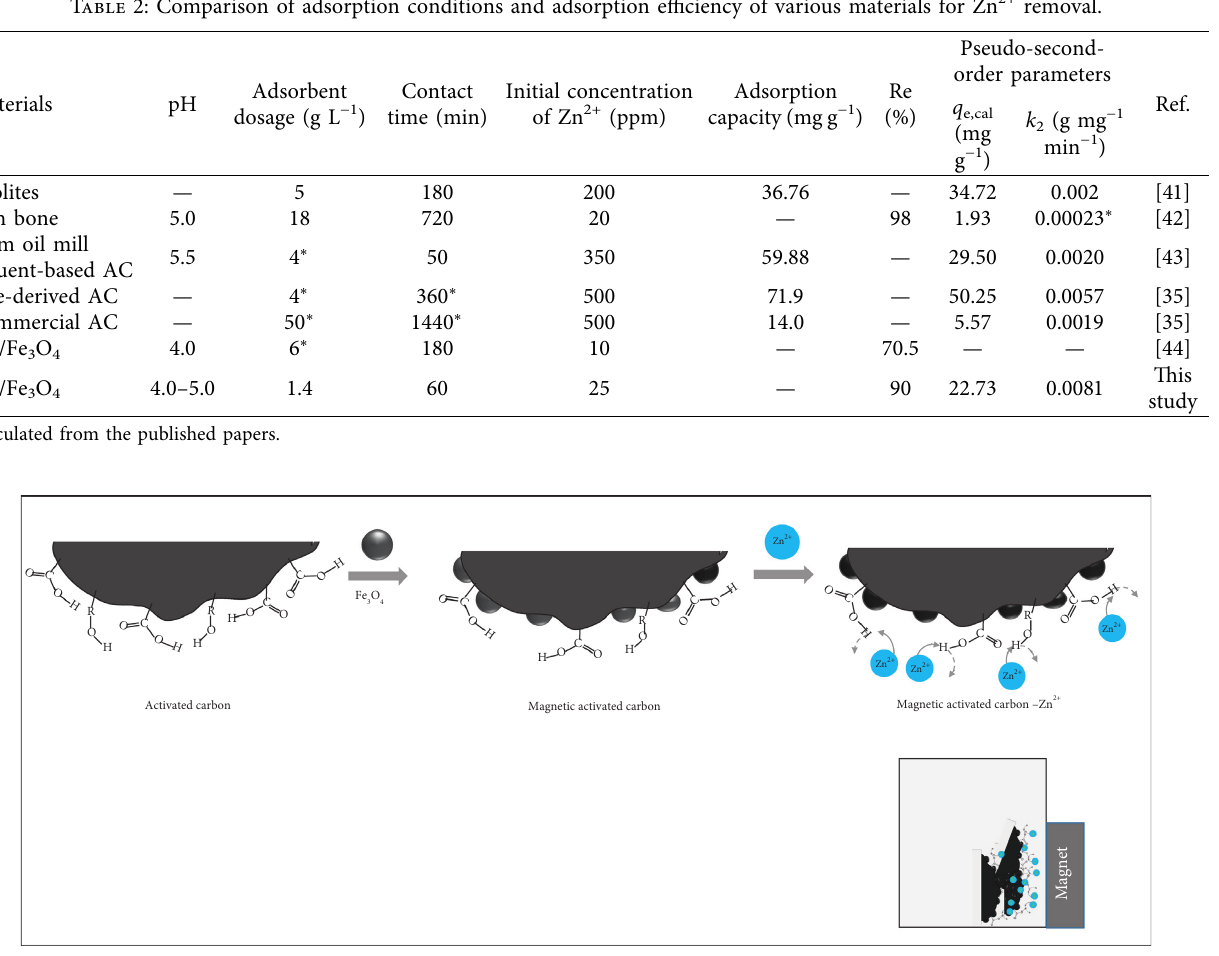
Table 2: Comparison of adsorption conditions and adsorption efficiency of various materials for Zn 2+ removal.